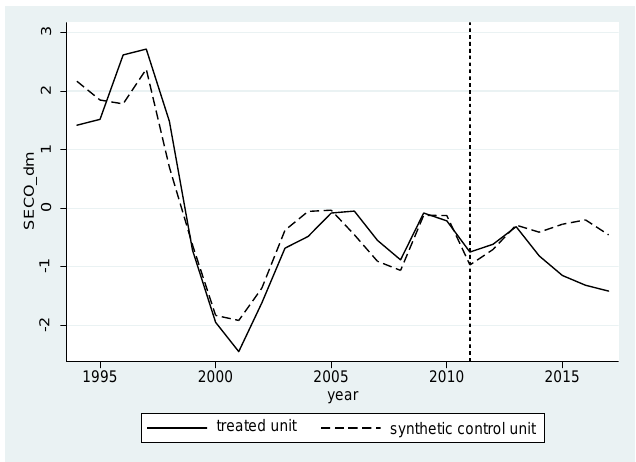
Figure 9. Outcome specification